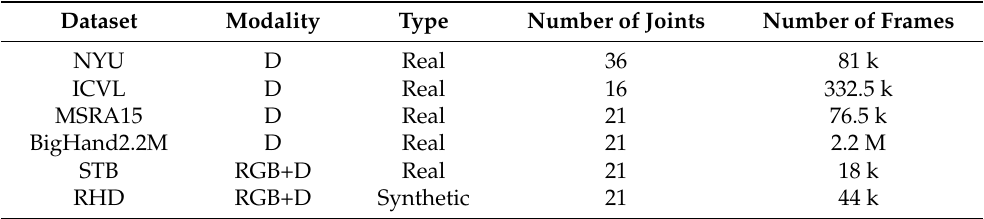
Table 1. Summary of hand pose estimation datasets commonly used in data augmentation using GANs.